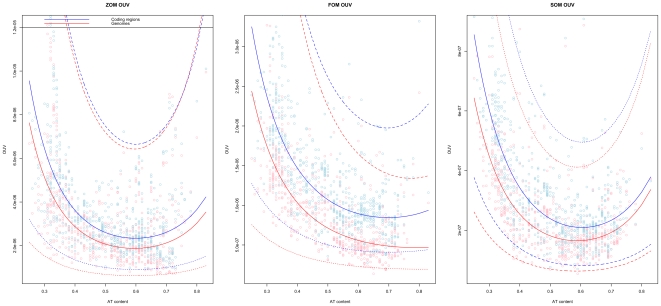
Oligonucleotide usage variance (OUV) based on ZOM, FOM and SOM models.OUV scores based on ZOM (left), FOM (middle), and SOM (right) measures are found on the vertical axis, with each respective chromosome, sorted from left to right by increasing AT content, on the horizontal axis. Red lines indicate whole chromosome OUV scores, including both coding and non-coding section, while blue lines represent concatenated open reading frames. Lower values mean better OUV approximations. Dotted lines represent 99% prediction intervals.